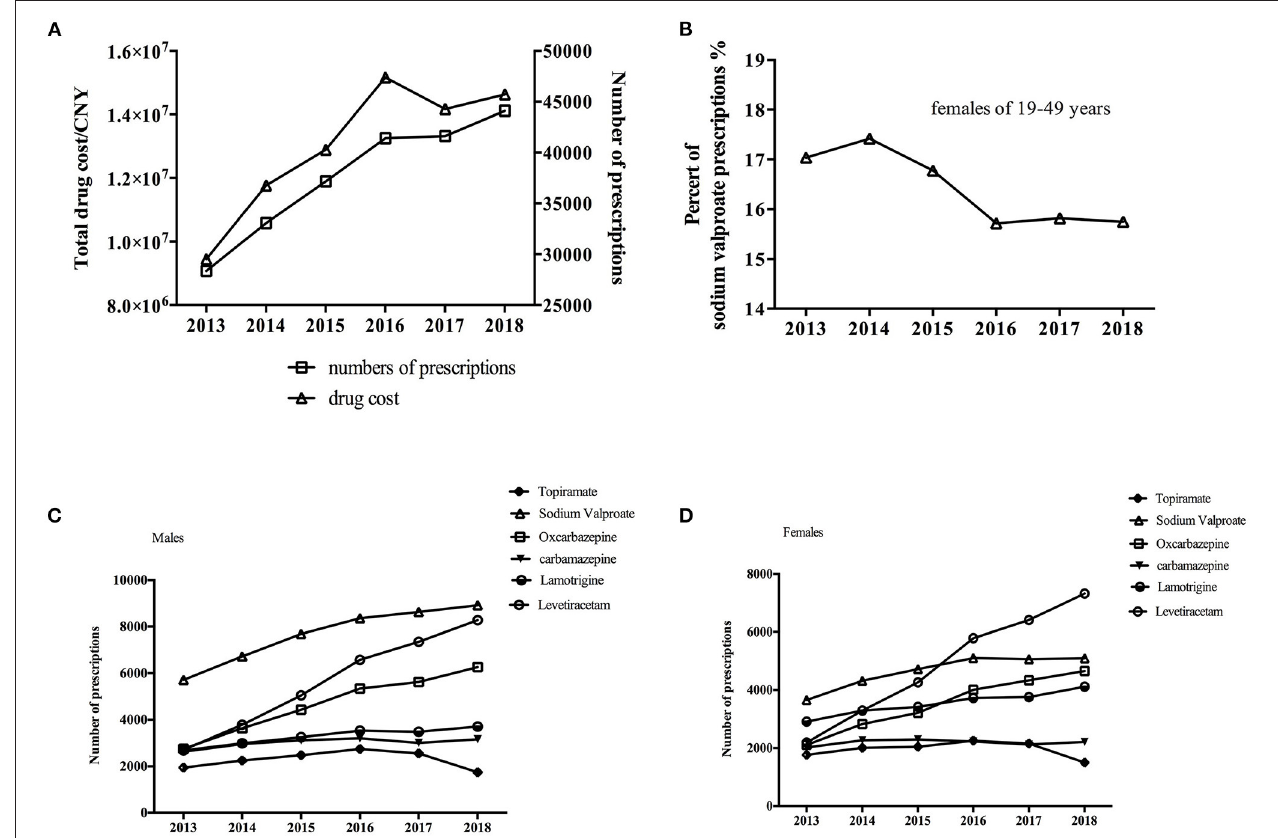
FIGURE 1 | (A) Trends in overall prescriptions and cost of anti-seizure medications (ASM) from 2013 to 2018. (B) Trends in sodium valproate use in females of child-bearing age (19–49 years old). Trends in individual ASM use in (C) males and (D) females from 2013 to 2018.